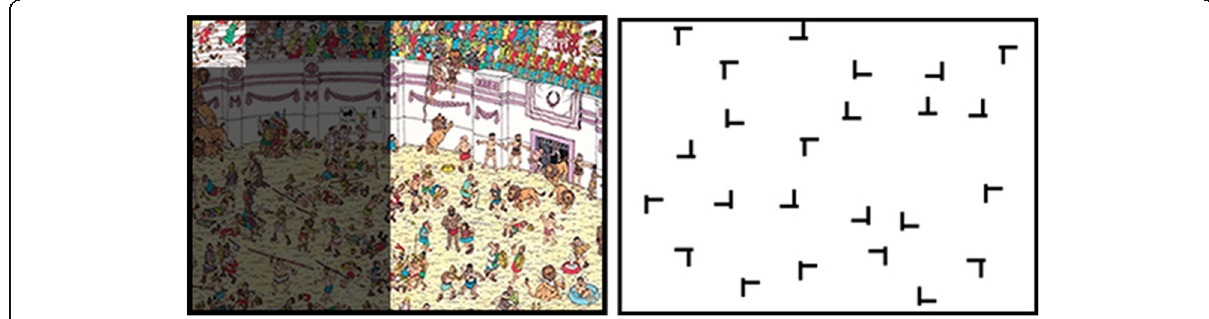
Fig. 1 Examples of stimuli used in Experiments 1 – 3 ( left ) and Experiment 4 ( right ). In the left panel , we also provide an example of what the opaque overlay looked like. The left side of the figure is what the images looked like with the overlay, and the right side of the figure is how images appeared without the overlay. We also showed one segment in the upper left corner without the overlay to give a sense of how large each segment